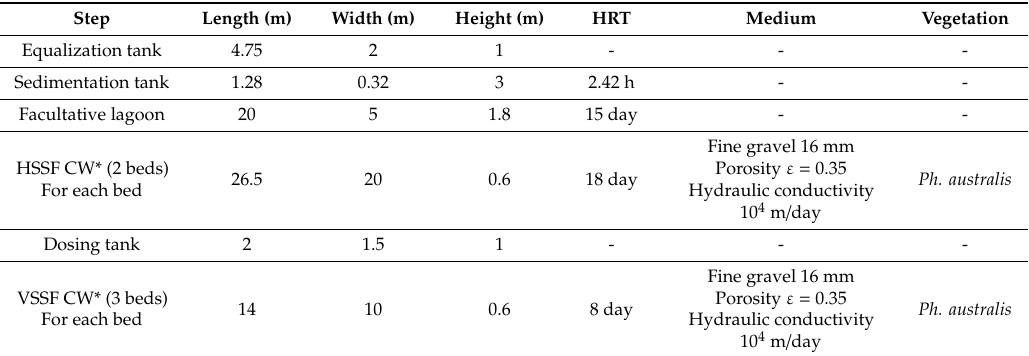
Table 3. The main design parameters of the different treatment steps.